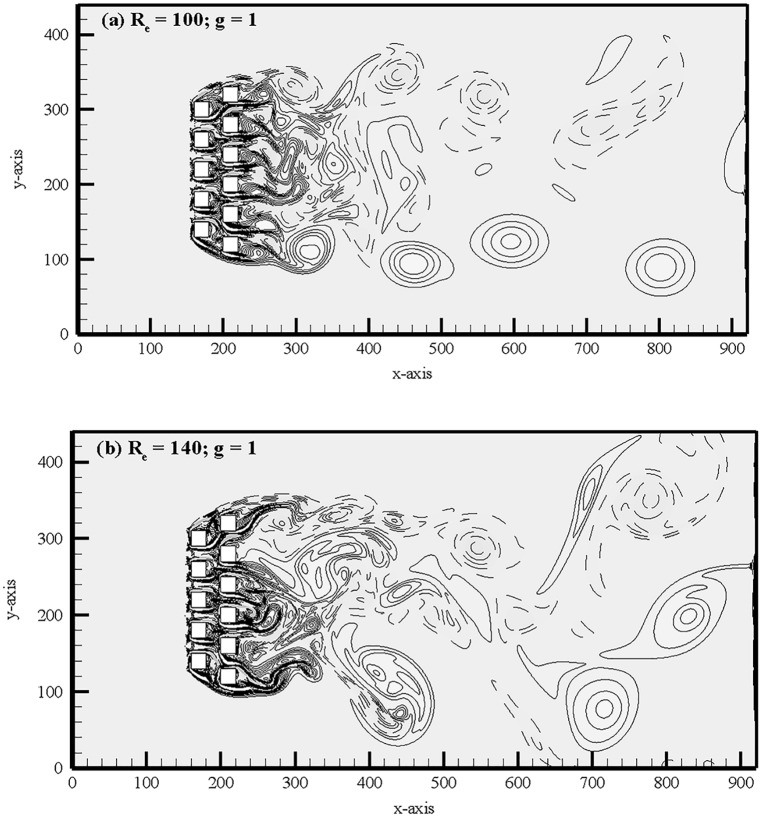
Instantaneous vorticity contours visualization at (a) (Re, g) = (100, 1) and (Re, g) = (140, 1).